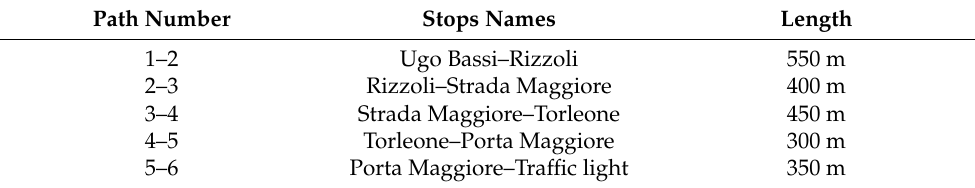
Table 1. Line 14—Outward journey. Names of the trolleybuses’ stops and traffic light on the final route.